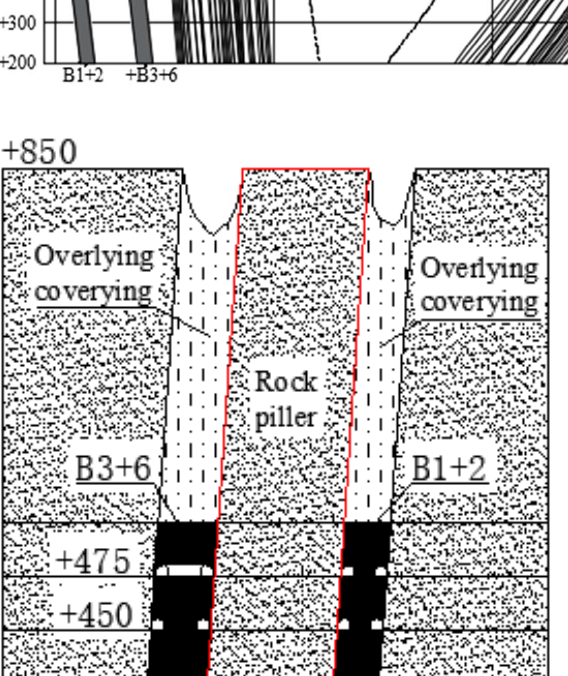
Figure 1. Nearly vertical coal seam occurrence and slicing